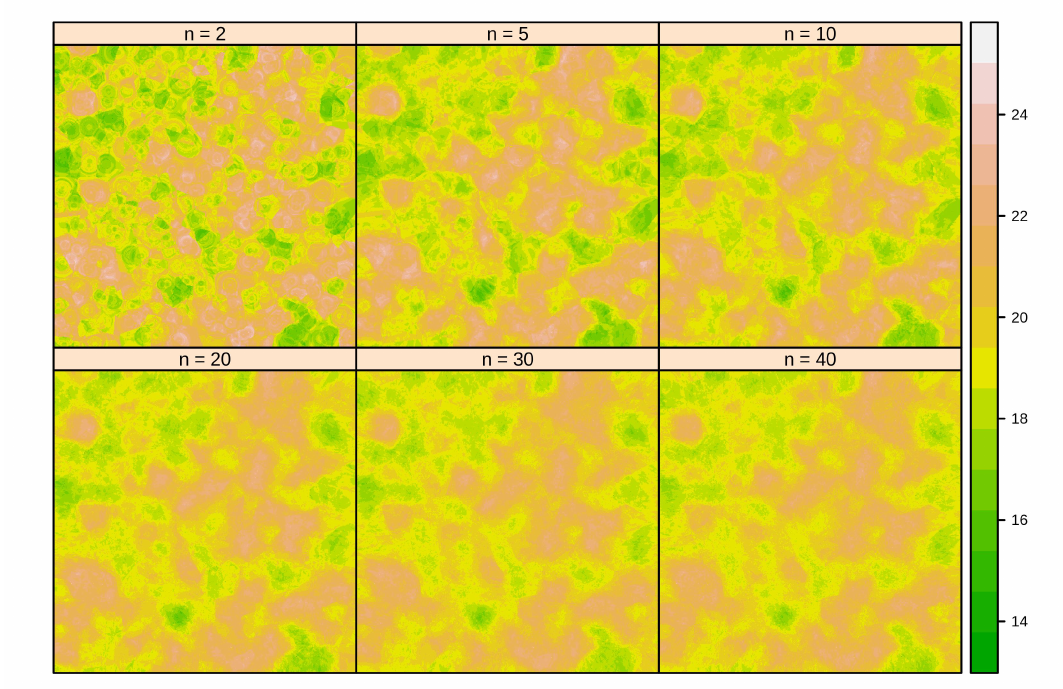
Figure 7. RFSI prediction maps made using 500 sample locations with nugget-to-sill ratio 0.25 and range 50, with different number of nearest locations ( n